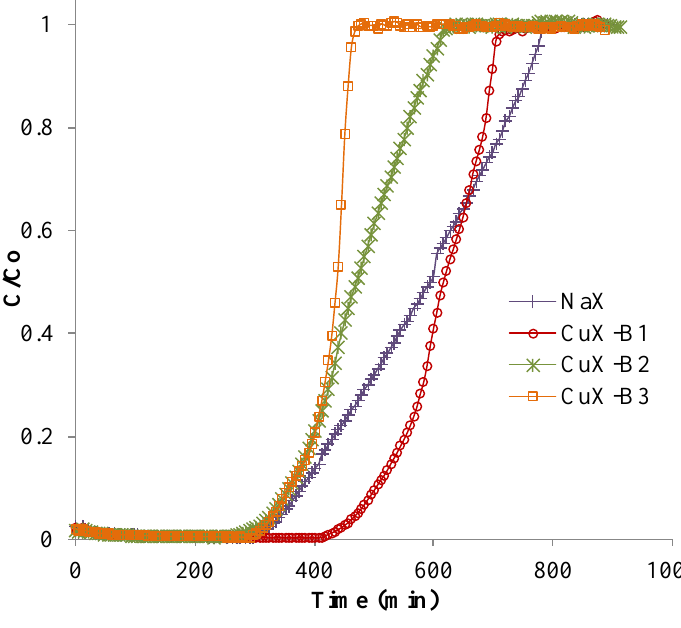
Figure 7. Adsorption breakthrough curves of toluene over NaX and copper-exchanged